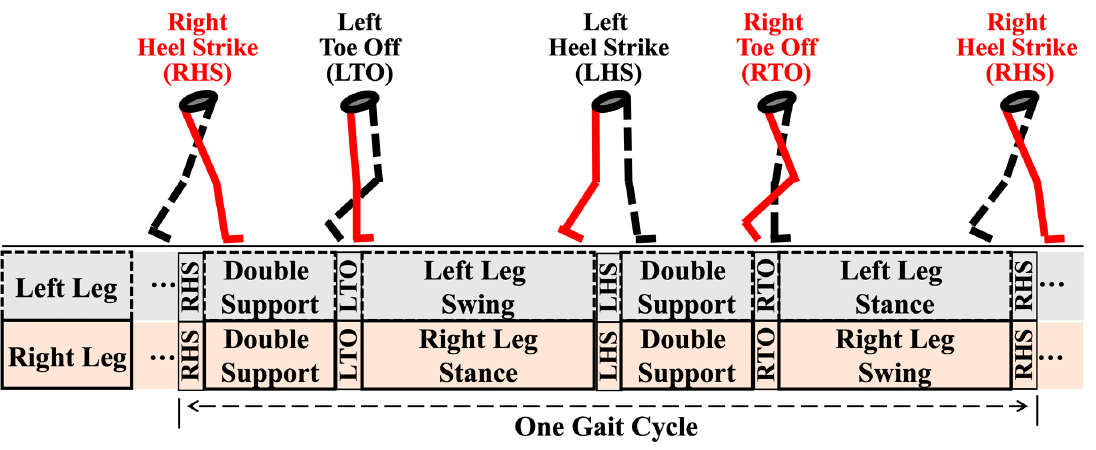
Figure 3. Critical moments (RHS, LTO, LHS, and RTO) and phases (double support, swing, and single leg stance) of one gait